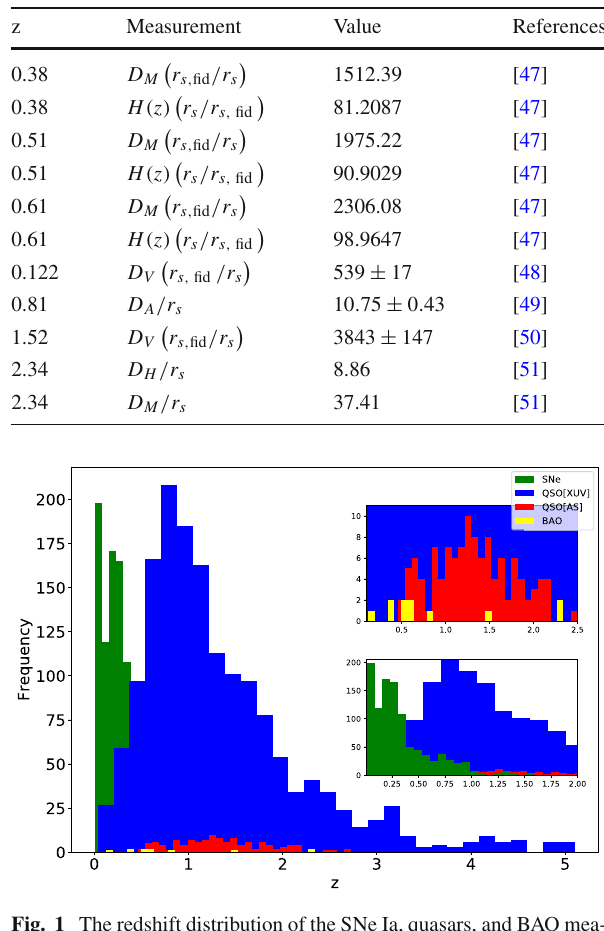
Table 1 The newest observations of BAO used in this analysis